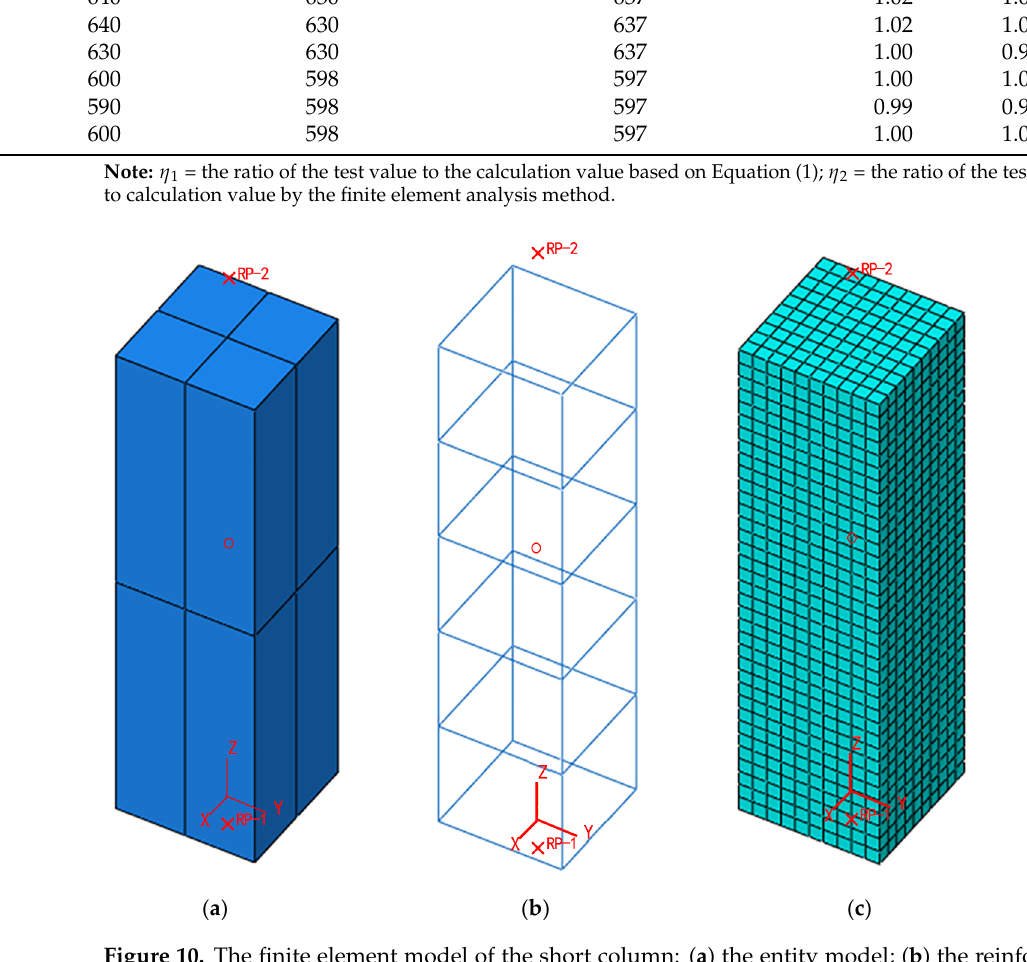
Figure 10. The finite element model of the short column: ( a ) the entity model; ( b ) the reinforcing element; and ( c ) the concrete unit.